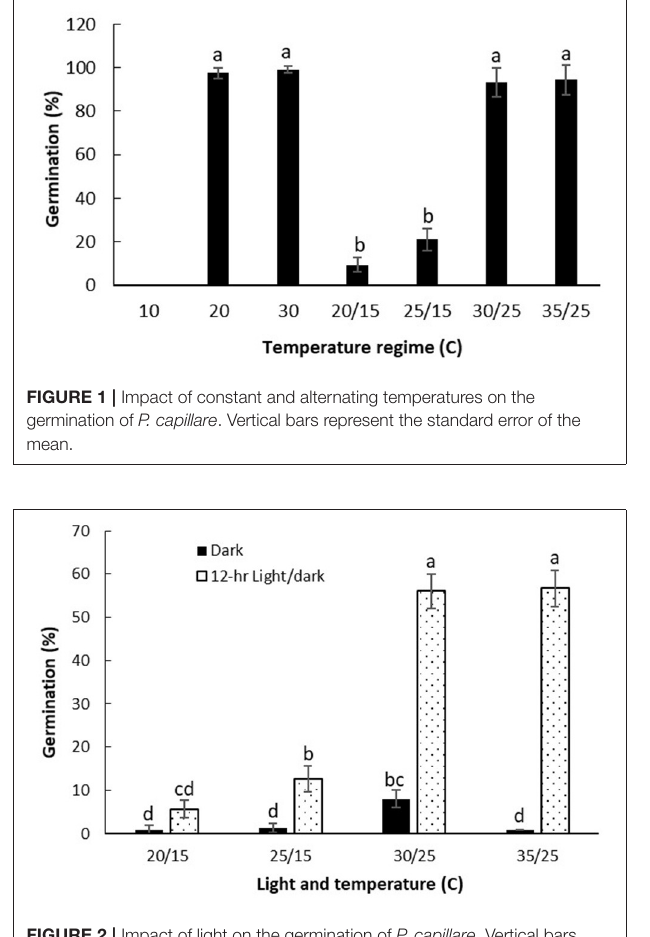
germination of witchgrass was 12.7, 48.0, and 56.7% at the temperatures of 25/15, 30/25, and 35/25 ◦ C, respectively.